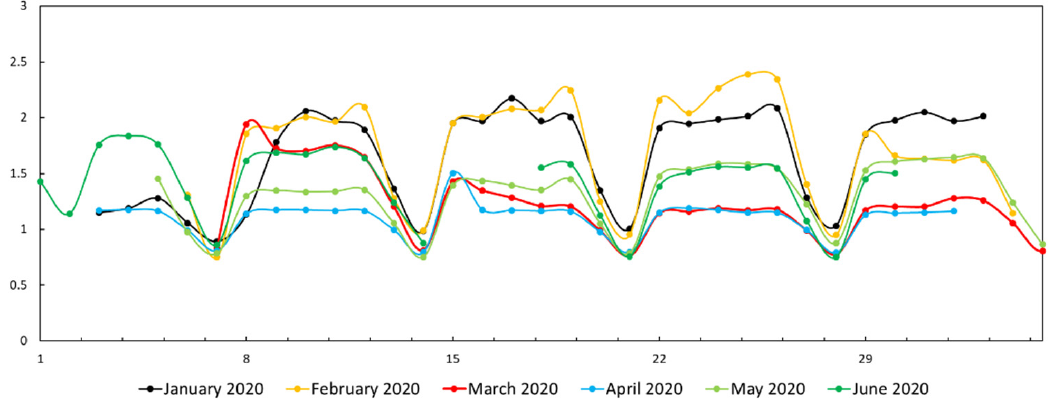
Figure 9. Daily traffic flows recorded in the city of Milan in the months of January–June 2020.